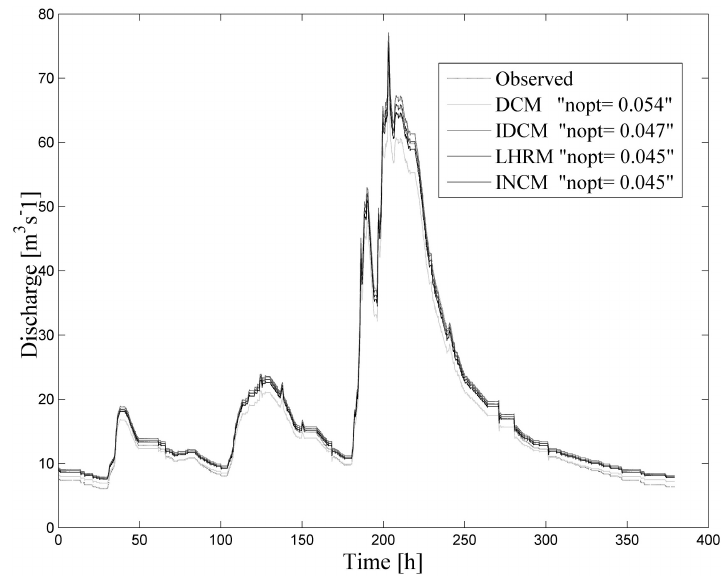
Figure 8. Observed and simulated discharge hydrographs at the Pfaffenthal gauged site in the event of January